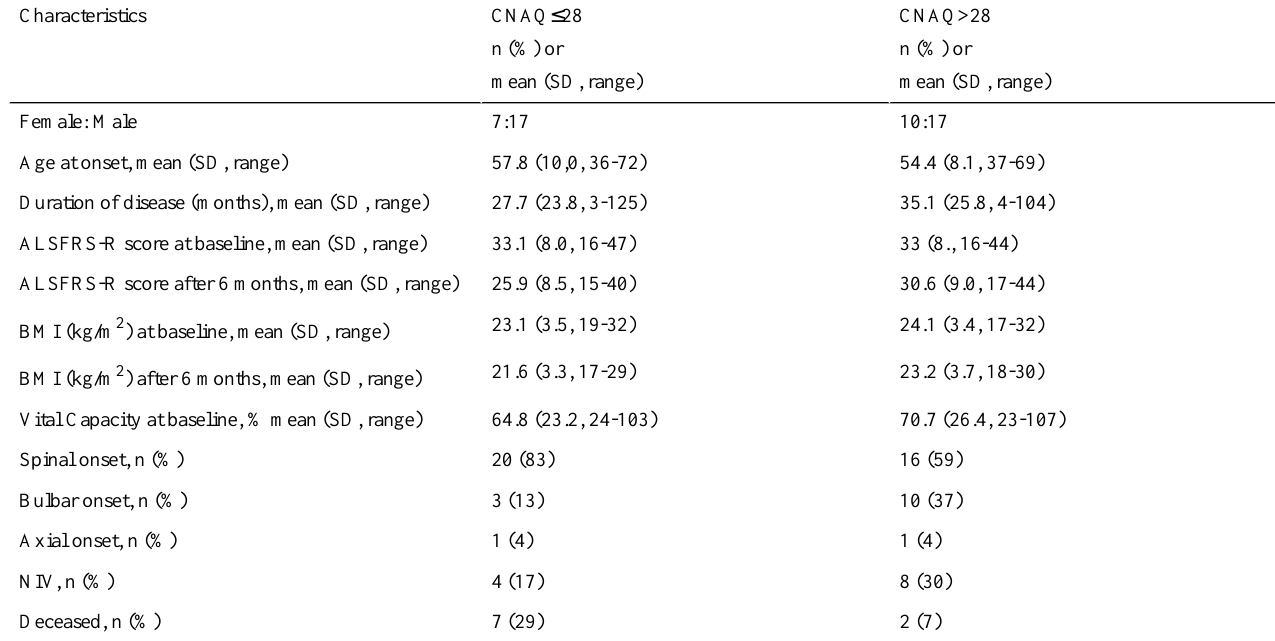
Table 2. Descriptive characteristics of the study population during baseline visit and after 6 months divided into CNAQ scores (CNAQ ≤ 28 and CNAQ >28). Numbers show mean, SD, and